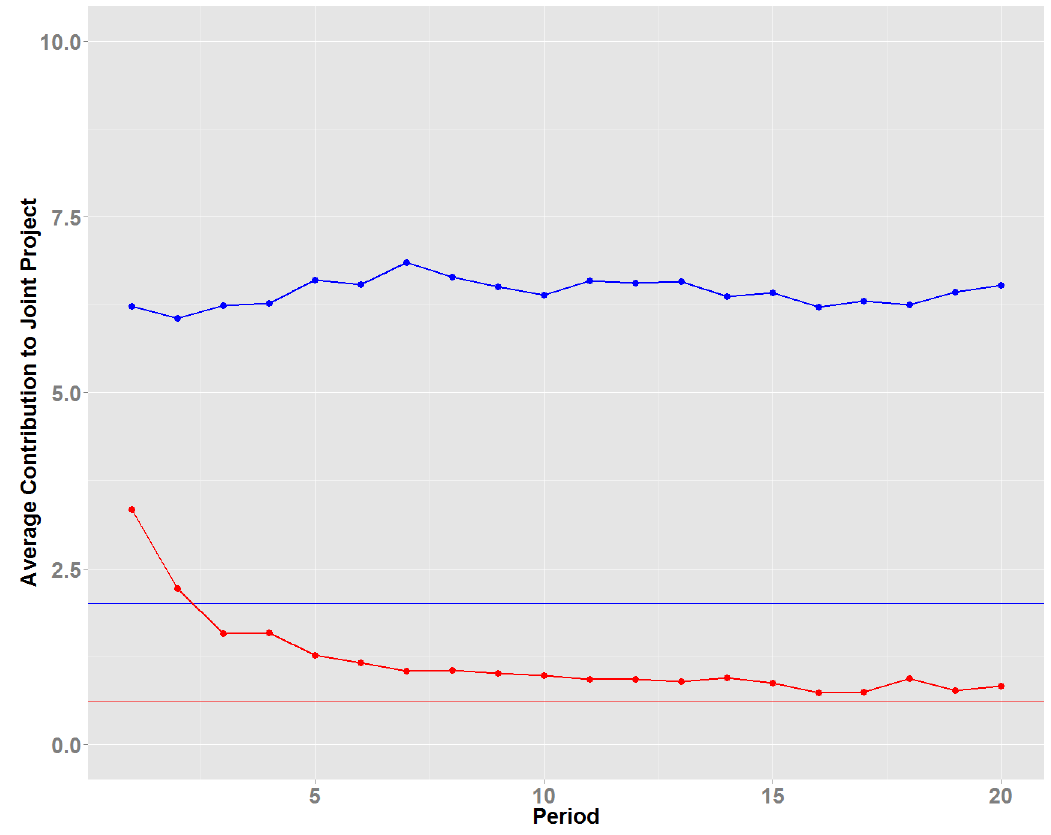
Figure 7. Average contribution to the joint project over 20 periods, Strategic complementarity; n = 5 (blue) and n = 2